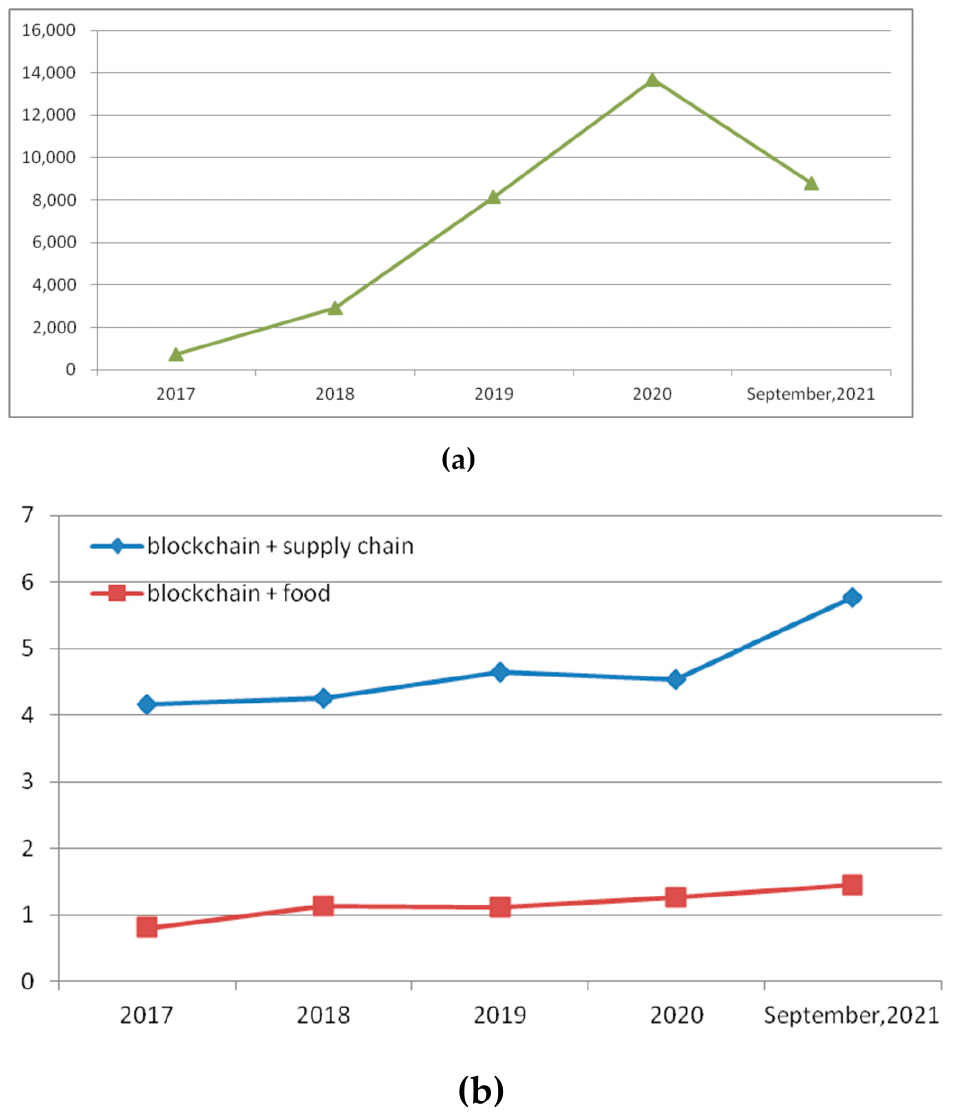
Figure 1. Publication trends: ( a ) blockchain, ( b ) percentages in publications about blockchain.